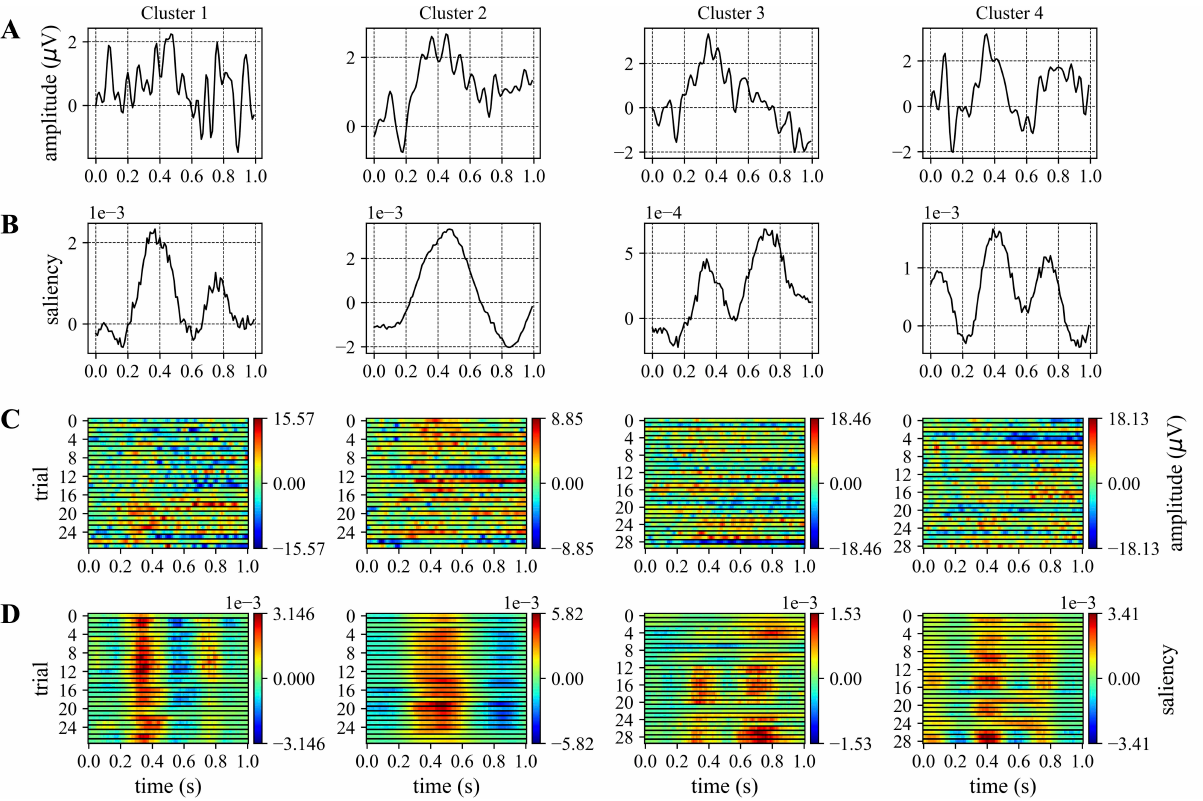
Fig. 11. Comparison between CNN-derived saliency and EEG-derived representations at single-subject and single-trial levels: distractor. These representations are displayed for one representative subject for each of the four clusters of Fig. 9 (each column of Fig. 11 is related to a specific cluster). (A,B) Evoked potentials directly derived from EEG trials (Fig. 10A) and temporal WS CNN-derived saliency patterns (Fig. 10B) at the level of single subject; both these representations involve averaging across trials of the same condition and across a subset of electrodes (FC1, FC2, C1, C2, CP1, CP2). See Section 2.3.5 for details. (C,D) Single EEG trials (Fig. 10C) and WS CNN-derived saliency pattern (Fig. 10D) at the level of single trials: each row corresponds to a trial, and the representation in each row still involves averaging across the subset of electrodes. In practice, the patterns in Fig. 10A and Fig. 10B correspond to averaging, across the rows, the representations in Fig. 10C and Fig. 10D,